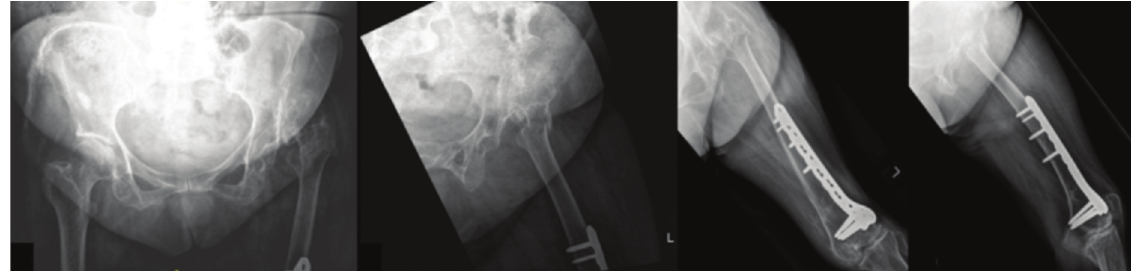
Pre-operative radiographs showed a left hip intertrochanteric fracture and concurrent left dysplastic hip. The left femur Fig. 1: radiographs showed left distal femoral plate proximally was more anterolateral due to altered femoral anatomy.